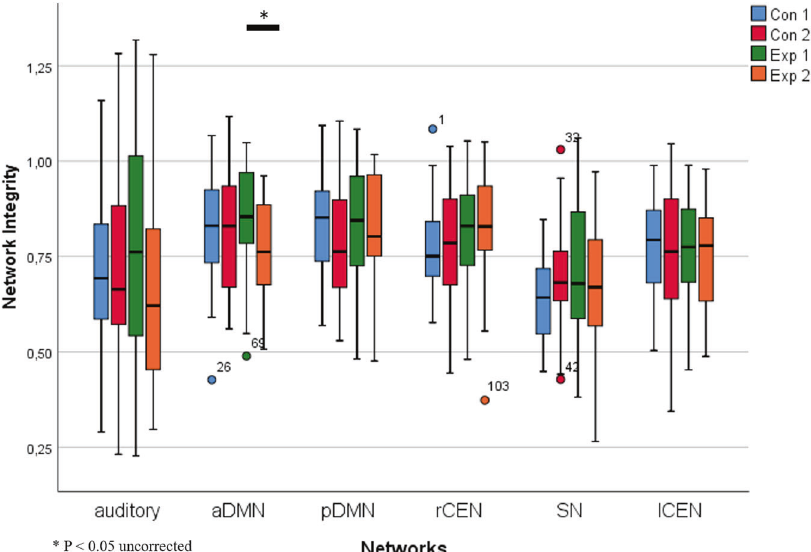
Fig. 5 Integrity of fMRI-based networks. Distribution of integrity indices is shown as boxplots. Con 1: active control group at T1 (before training), Con 2: active control group at T2 (after training), Exp 1: experimental group at T1 (before training), Exp 2: experimental group at T2 (after training).